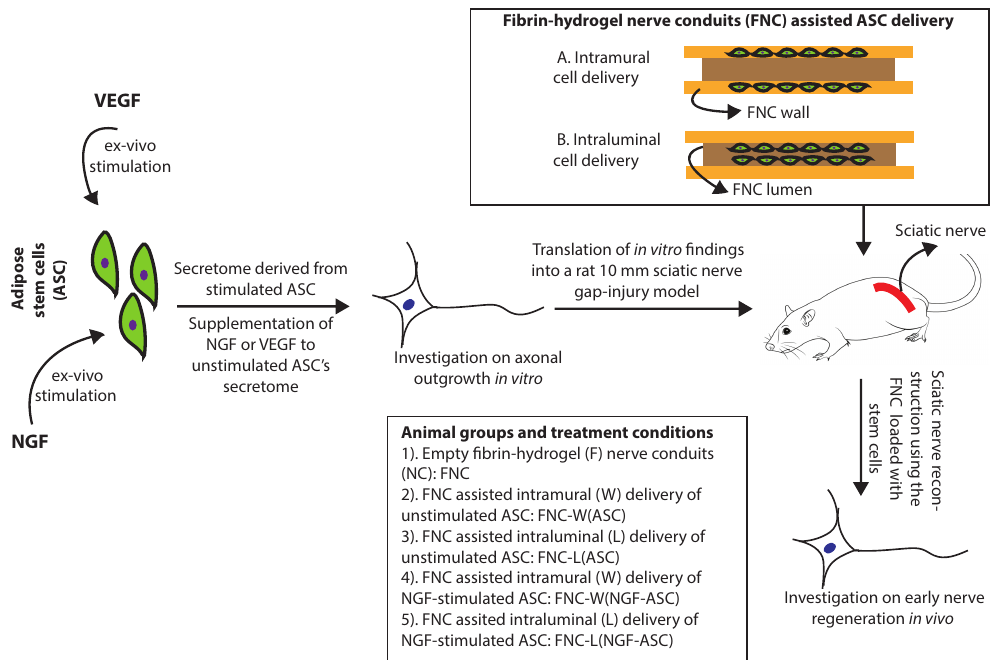
Figure 1. Ex-vivo stimulation of adipose stem cells using growth factors and fibrin-hydrogel nerve conduits assisted stem cell delivery strategies for enhancing the axonal